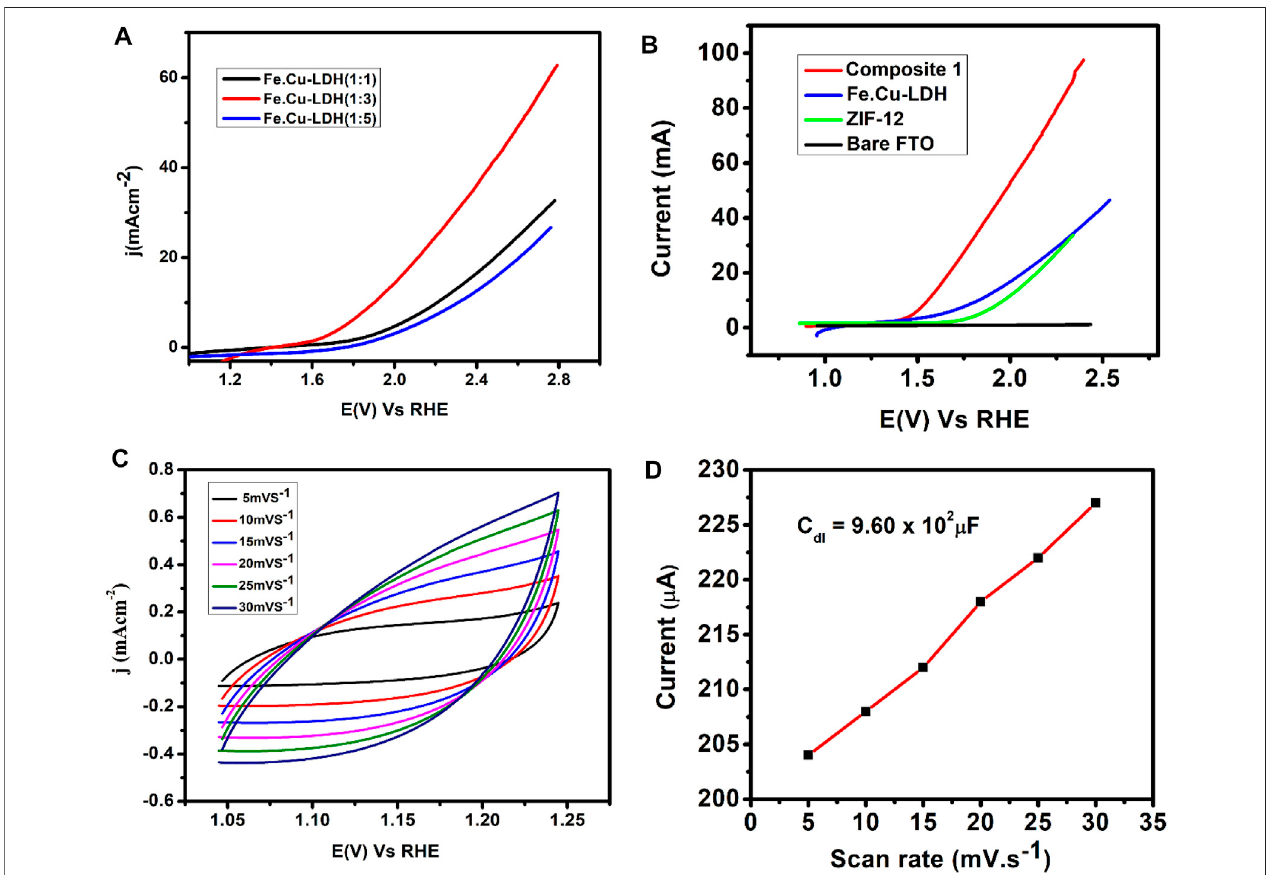
FIGURE 4 | (A) LSV curves of FeCu-LDH with different ratios (B) Linear sweep voltammograms of LDH, ZIF-12, and 1 , (C) Cyclic voltammogram of non-faradaic region of Composite 1 at different scan rates, and (D) plot of anodic current vs scan rates of 1 coated electrode KOH solution (1 mol L − 1 ) as an electrolyte.